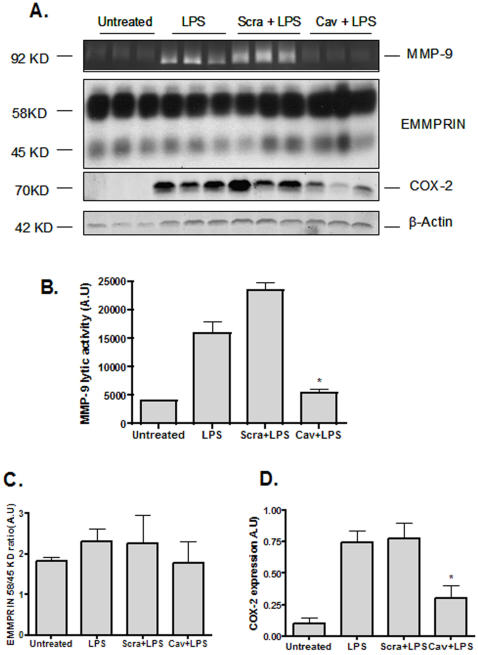
Cavtratin, MMP-9, COX-2 and EMMPRIN in LPS-challenged Raw-264.7.A- Top, MMP-9 activity in the culture supernatant from Raw-264.7 macrophages. 1×106 cells were pre-incubated in a serum-free medium with Cavtratin or scrambled peptides (10 µM) for a period of 8 hours. Thereafter, LPS (10ng/mL) was added and the culture media was collected after 20 hours of LPS addition and centrifuged for 5 minutes at 2000 rpm at 4C and subjected to gelatin zymography. Middle top, representative western blot showing EMMPRIN expression in total cell lysates obtained from LPS-stimulated Raw-264.7 cells. Middle bottom, representative western blot for COX-2 expression in total cell lysates obtained from LPS-stimulated Raw-264.7 cells. Bottom panel, representative western blot showing β-actin expression. B- Quantification of MMP-9 lytic activity in the culture supernatant. * P<0.001. C- Quantification of EMMPRIN expression levels. Data presented were normalized by β−actin expression. D- Quantification of COX-2 expression levels. Data presented were normalized by β−actin expression. * P<0.001